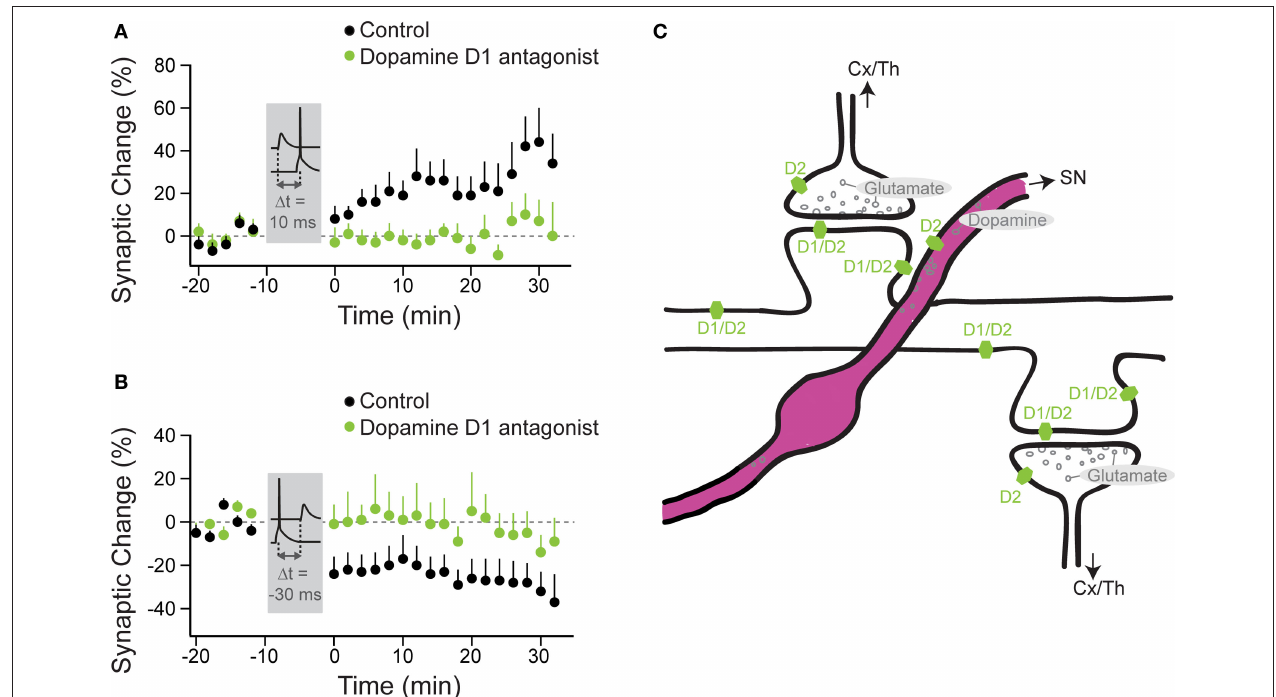
Figure 2 | Timing-dependent LTP and LTD are under the control of dopamine D1/D5 receptors in striatal principal neurons. Anatomy of neuromodulatory fibers and the respective receptors as exemplified for striatal dopamine. (A) t-LTP was induced under control conditions (black circles) with a STDP protocol, where the AP followed the EPSP by 10 ms ( ∆ t = 10 ms). (B) t-LTD was induced under control conditions with a protocol, where the EPSP followed the AP by 30 ms ( ∆ t = − 30 ms). No plasticity was observed with these two protocols, when